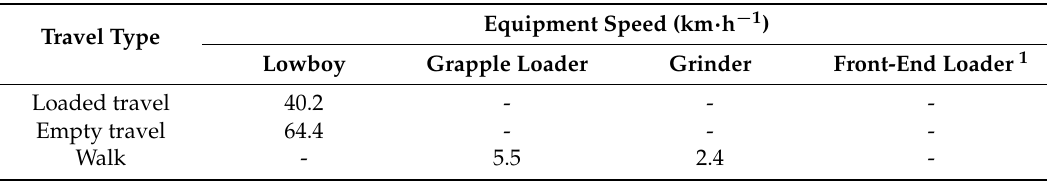
Table 4. Travel speeds of equipment applied in the